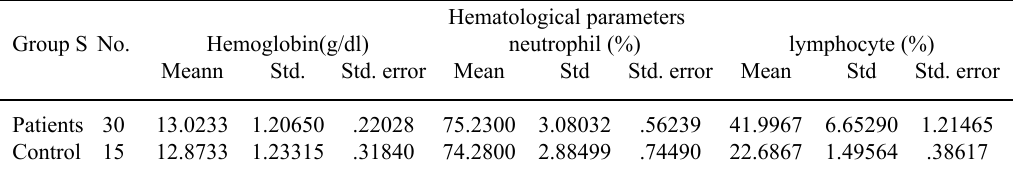
table 5. Haematological parameters in CMV patients Hematological parameters Group S No. Hemoglobin(g/dl) neutrophil (%)